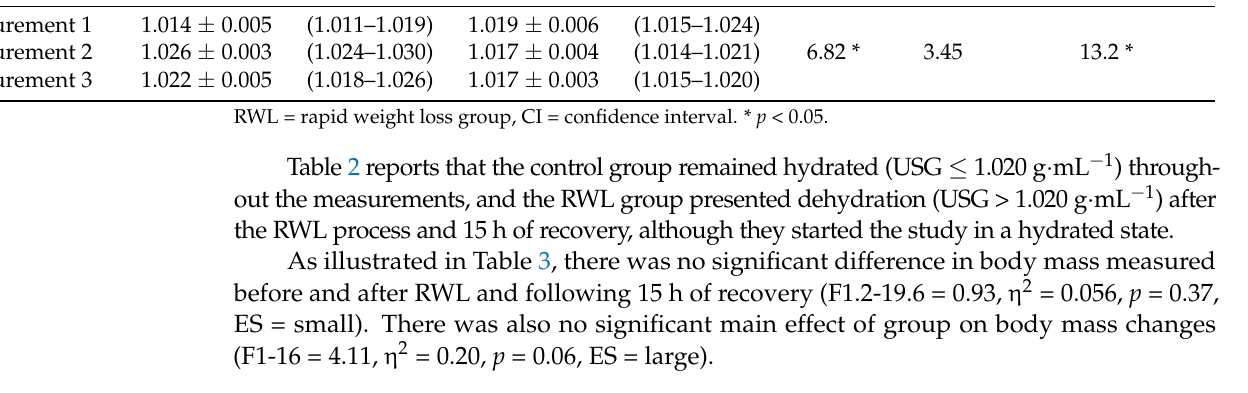
Table 3. Changes in body mass in RWL and control groups among measurements.